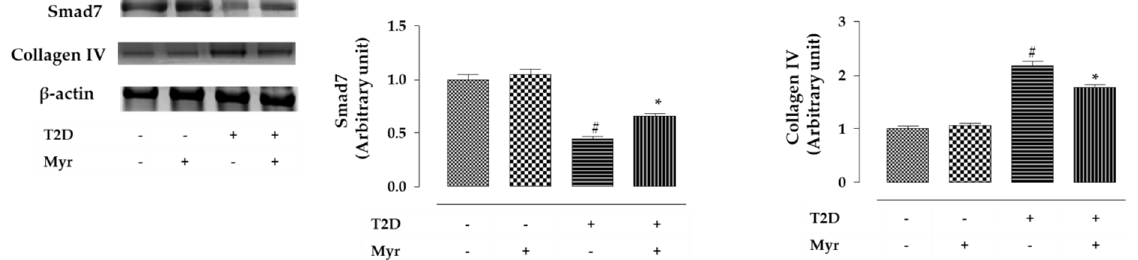
Figure 12. The effects of Myr on different signal proteins in the kidneys of T2D rats. ( a ) The immunoblot images showing the effects on the expressions of Bad (in mitochondria), Bcl-2, Cyt C (in cytosol), cleaved caspase 9, and cleaved caspase 3 involved in apoptosis. ( b ) The graphs showing the densitometric analysis of the bands of apoptotic factors. ( c ) The immunoblot images showing the effects on the expressions of P-I κ B α (in cytosol) and P-NF- κ B (in nucleus) involved in inflammation. ( d ) The graphs showing the densitometric analysis of the bands of inflammatory factors. ( e ) The immunoblot images showing the effects on the expressions of Keap1 (in cytosol) and P-Nrf-2 (in nucleus) involved in redox defense. ( f ) The graphs showing the densitometric analysis of the bands of redox defense factors. ( g ) The immunoblot images showing the effects on the expressions of TGF- β 1, P-Smad3, Smad7, and collagen IV involved in fibrosis. ( h ) The graphs showing the densitometric analysis of the bands of fibrotic factors. Myr was effective in reducing T2D-induced increase in the expressions of Bad (in mitochondria), Cyt C (in cytosol), cleaved caspase 9, cleaved caspase 3, P-I κ B α (in cytosol), and P-NF- κ B (in nucleus), Keap1 (in cytosol), TGF- β 1, P-Smad3, and collagen IV in rat kidneys, while it activated the expressions of Bcl-2, P-Nrf-2 (in nucleus), and Smad7 in the renal cells of T2D rats. The intensity of normal control band was assigned 1. β -actin served as the loading control for normalization. Data are expressed as mean ± SD ( n = 6). # Values significantly ( p < 0.01) differed from the normal control (T2D − ) group. * Values significantly ( p < 0.05) differed from the diabetic control (T2D+) group. ** Values significantly ( p < 0.01) differed from the diabetic control (T2D+) group.